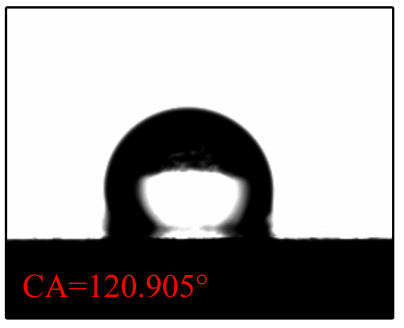
Figure 6. Wettability test of uncorroded